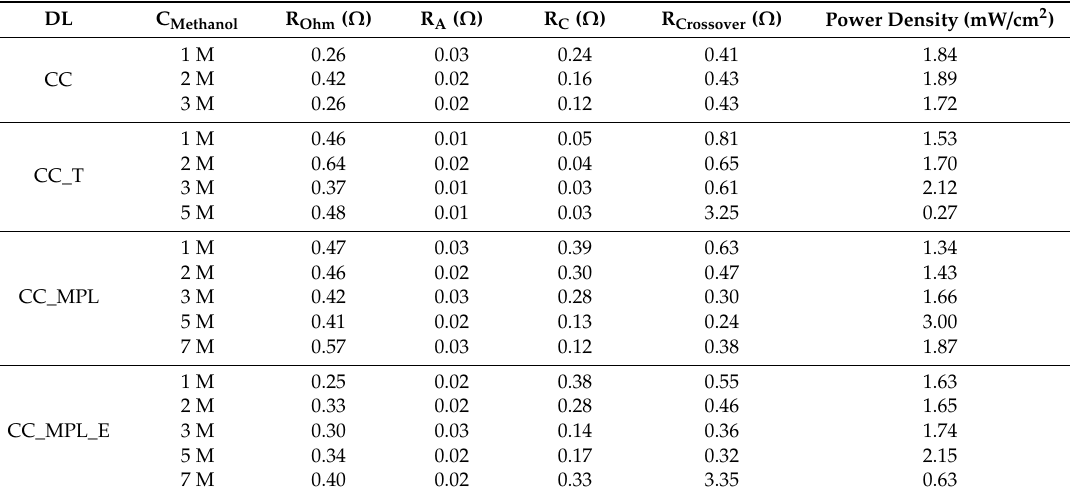
Table 2. Electrochemical impedance spectroscopy (EIS) data estimated from the EEC proposed in Figure 3 for di ff erent carbon cloths as anode di ff usion layer (ADL) and the maximum power density achieved for each